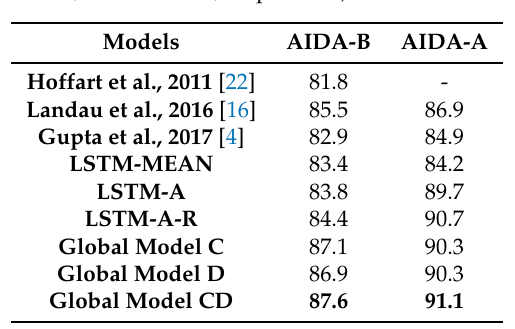
Table 5. F1 scores of different models on CoNLL (%). The performance of the state-of-the-art models are reported in [4] (Hoffart et al., Landau et al., Gupta et al.).